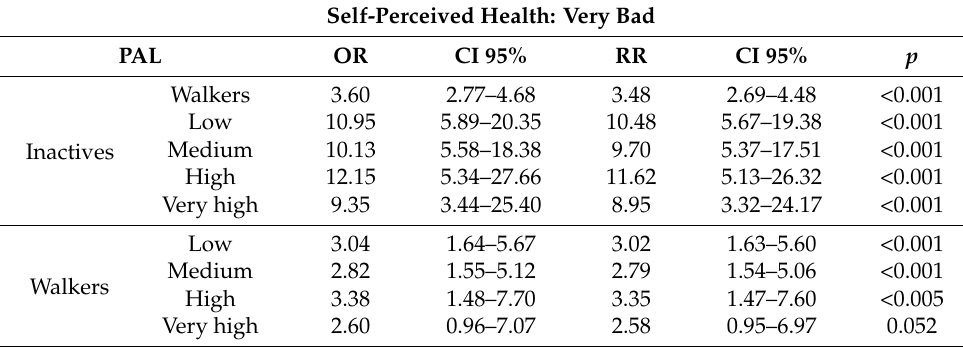
Table 4. Probability and relative risk of perceiving health as very poor, poor, or fair, according to the physical activity level in the Spanish population through the ENSE